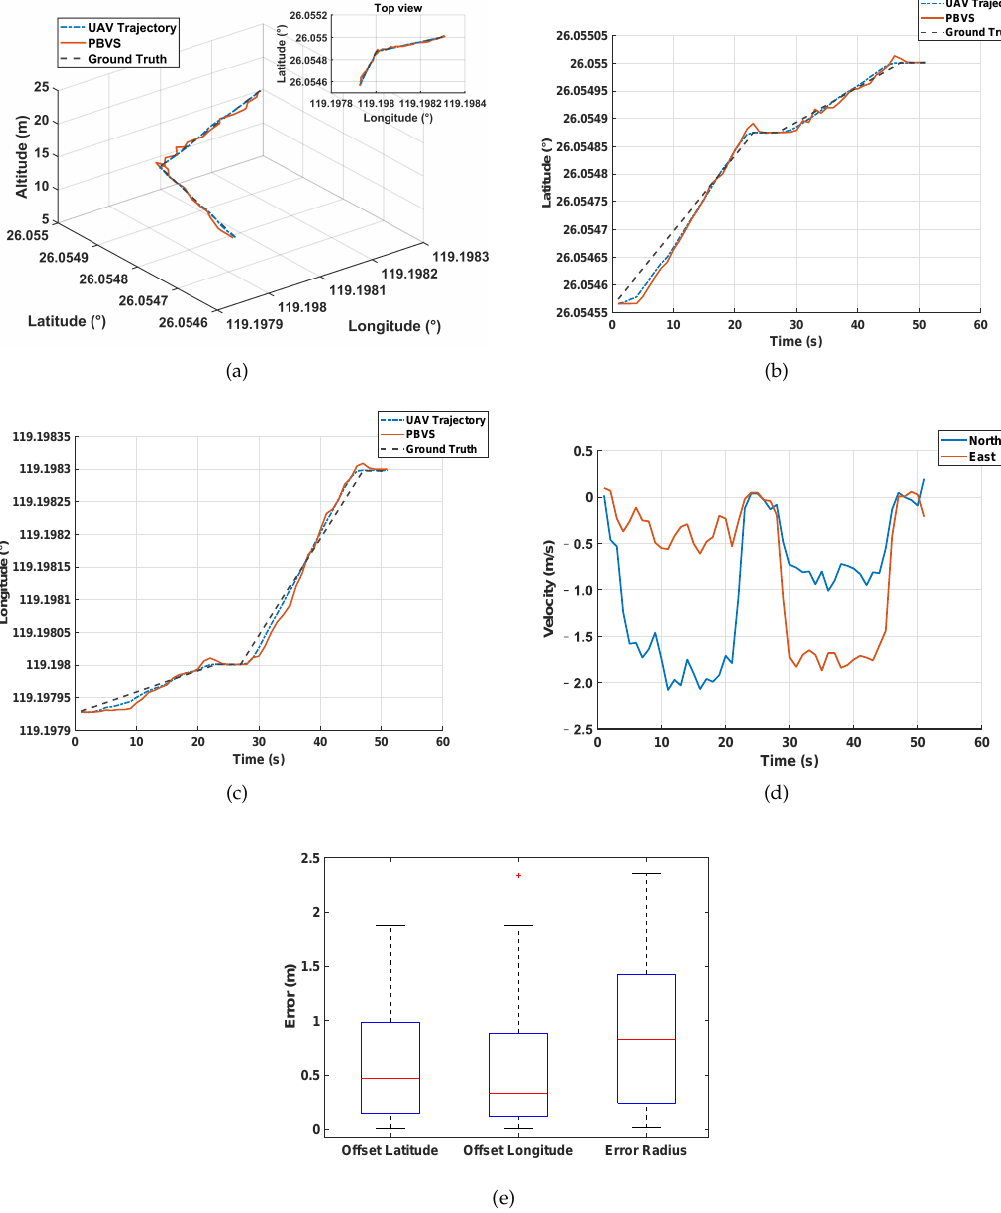
Figure 14. Actual UAV flight experiment: ( a ) flight three-dimensional diagram; ( b ) latitude diagram; ( c ) longitude diagram; ( d ) velocity diagram; and ( e ) error